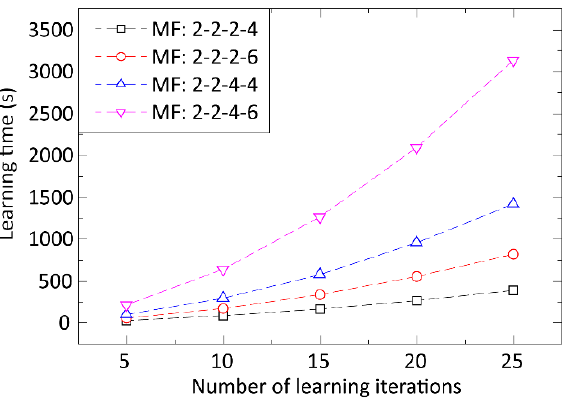
Figure 3. Learning time as a function of the learning iteration number, the configuration, and the total number of membership functions (MF).